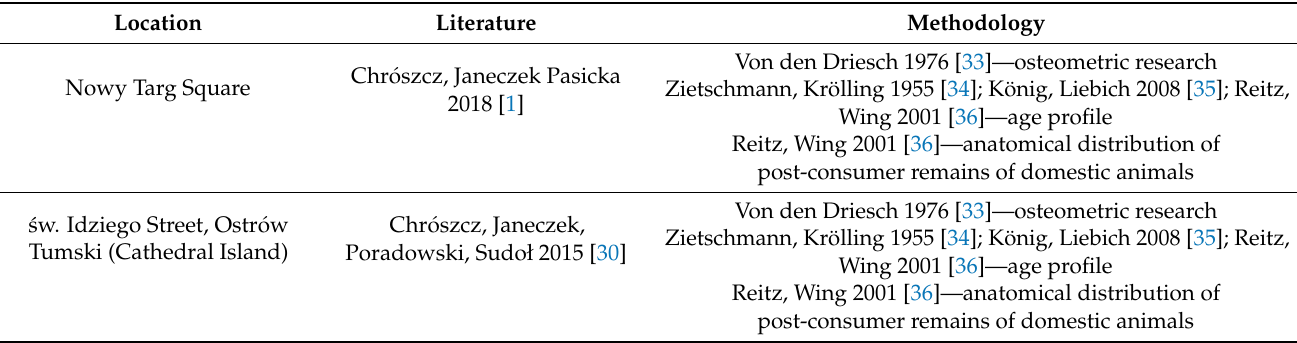
Table 2. List of methodologies used in the archaeozoological research according to the authors of the publications. Description: M.